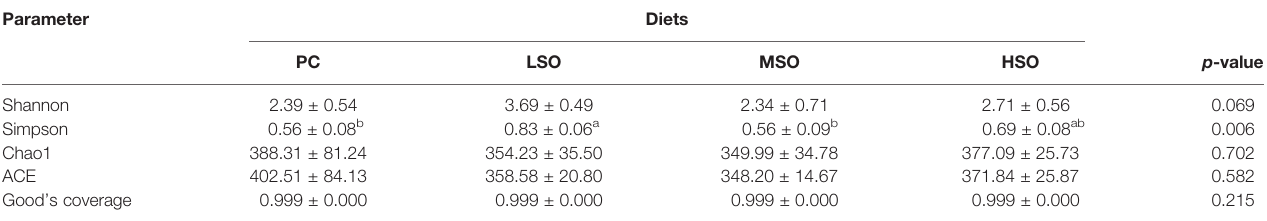
TABLE 8 | Alpha diversity parameters of intestinal microbiota of shrimp in this study. Parameter Diets PC Shannon